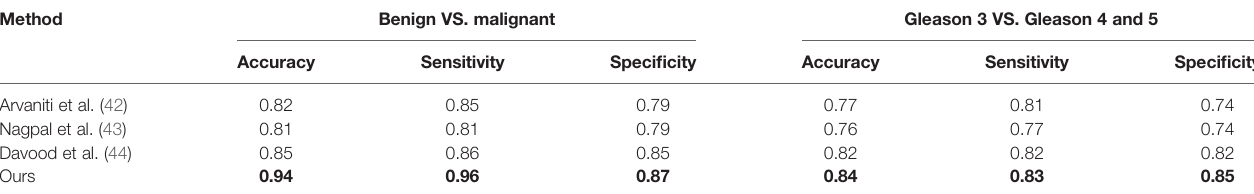
TABLE 5 | Comparison of the proposed method with several recently proposed methods.